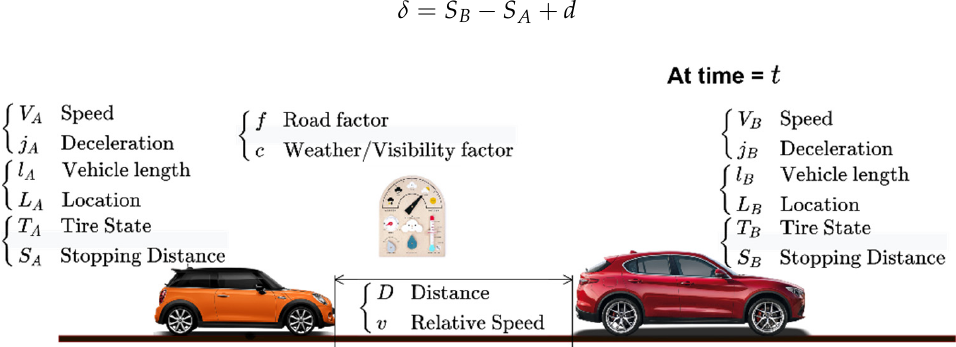
Figure 12. Parameters affecting the sufficient safe driving gap provided that IoV is used to broadcast these parameters to the surrounding vehicles in real time.